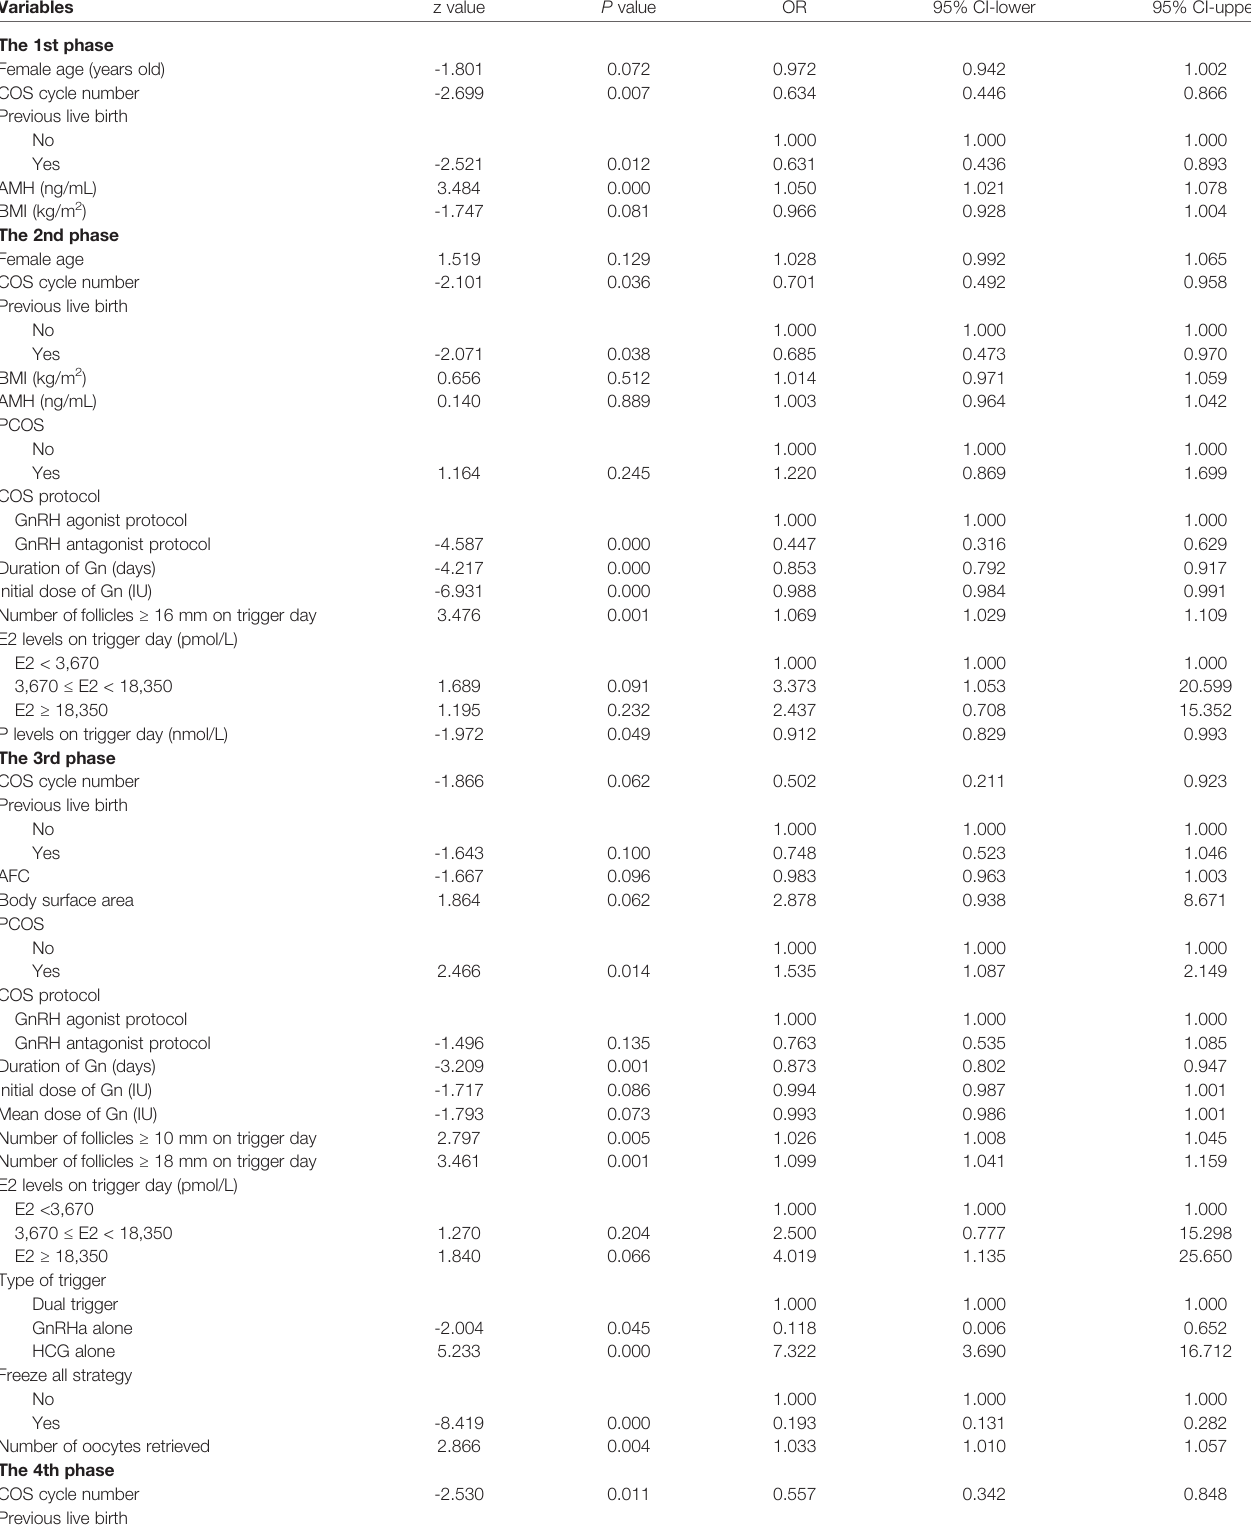
TABLE 3 | Multivariable analysis of multiphase variables in predicting